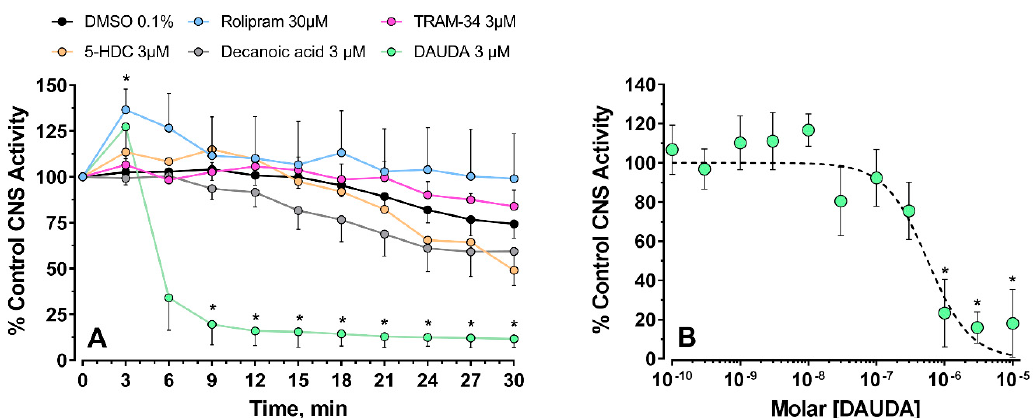
Figure 3. Recording the activity of Drosophila CNS under pharmacological screen. ( A ) CNS activity was recorded for 30 min and the firing rate expressed relative to the control (pretreatment) observed at the start of the recording. Asterisks indicate significant difference from DMSO controls (* p < 0.05). ( B ), Non-linear fit of log-transformed concentrations of 11-dansylamino undecanoic acid (DAUDA), showing a significant inhibition of the CNS activity at 1 µ M and higher concentrations (* p < 0.004 or less). In all cases, symbols are means ±